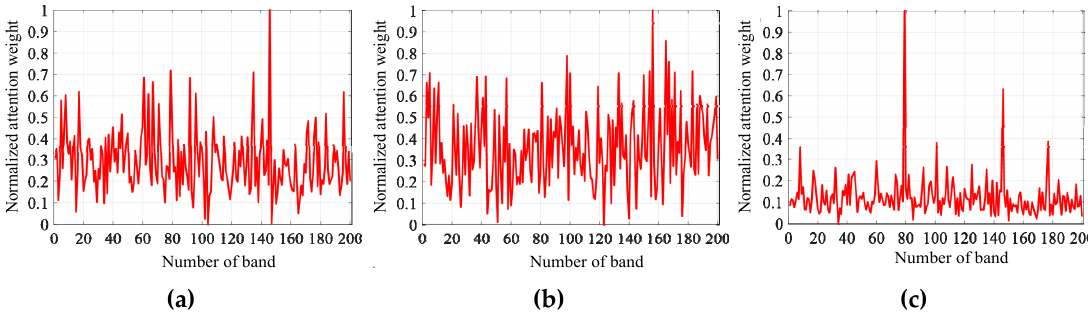
Figure 12. Visualization of attention weights for the head 2, layer 2 of T-SST on the Indian Pines dataset. ( a ) Dependency relations between the band 1 and another band; ( b ) dependency relations between the band 100 and another band; ( c ) dependency relations between the band 200 and another band.